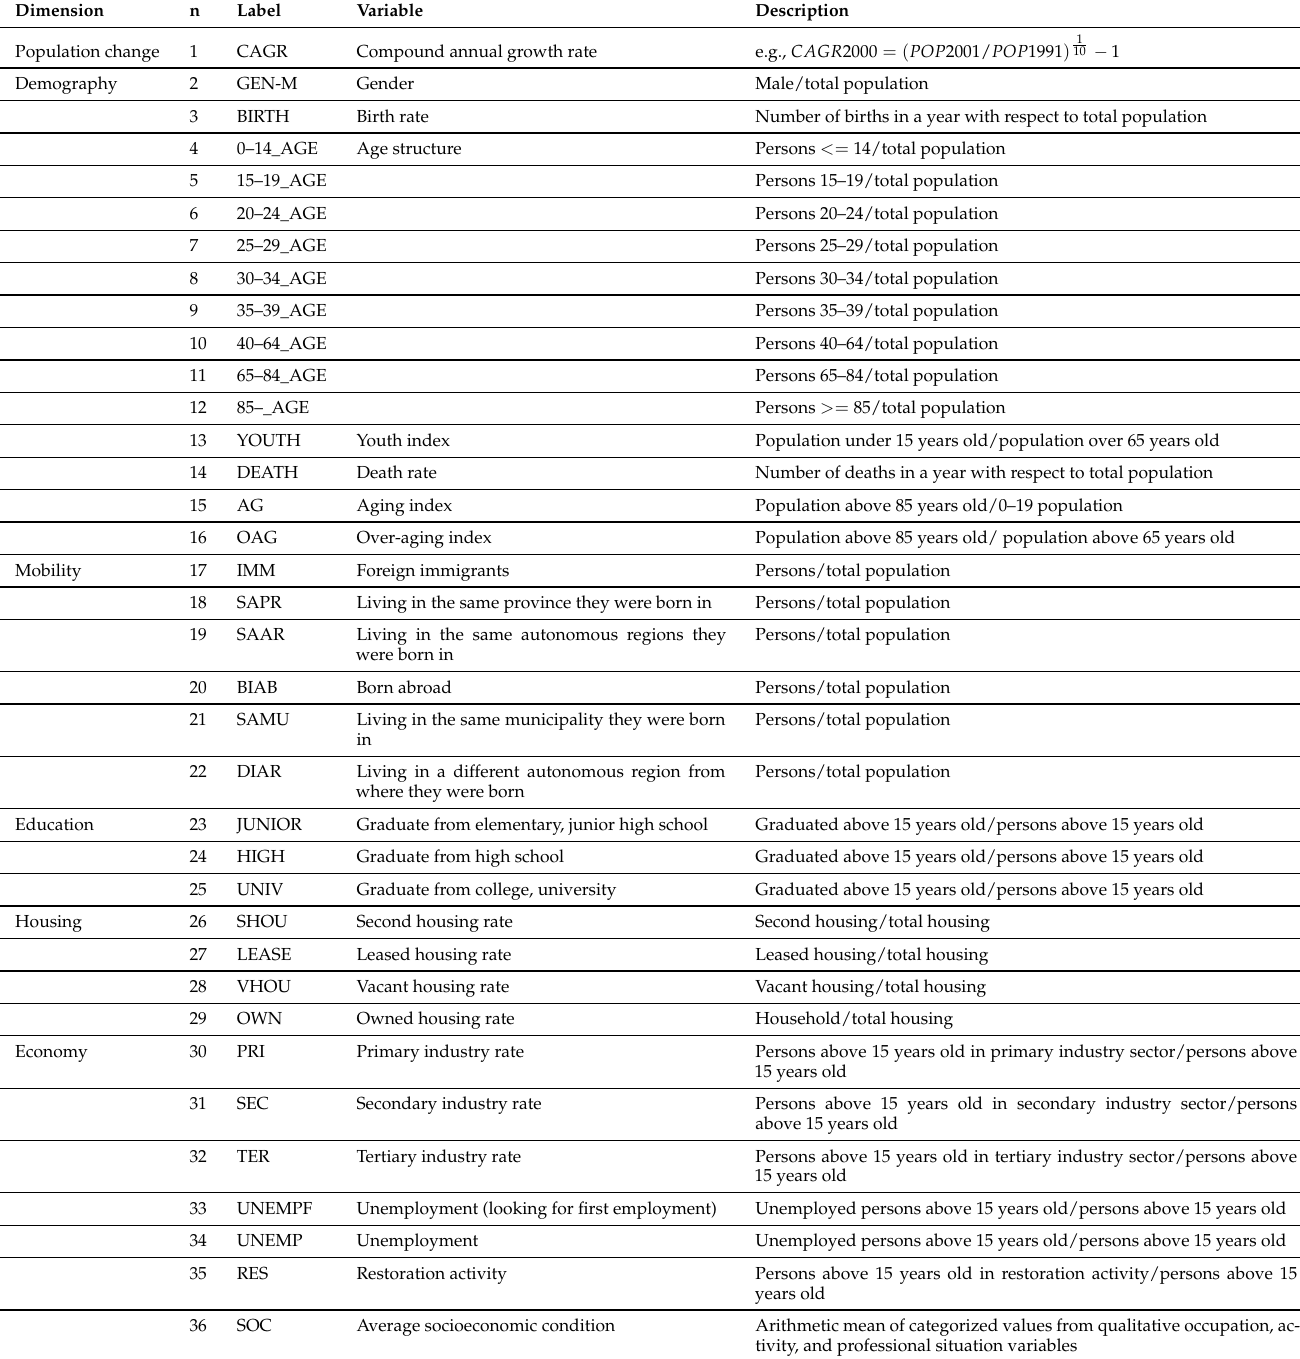
Table 1. Considered variables for the characterization of shrinkage. Definition, description, and identifier code used. Source: Spanish National Institute of